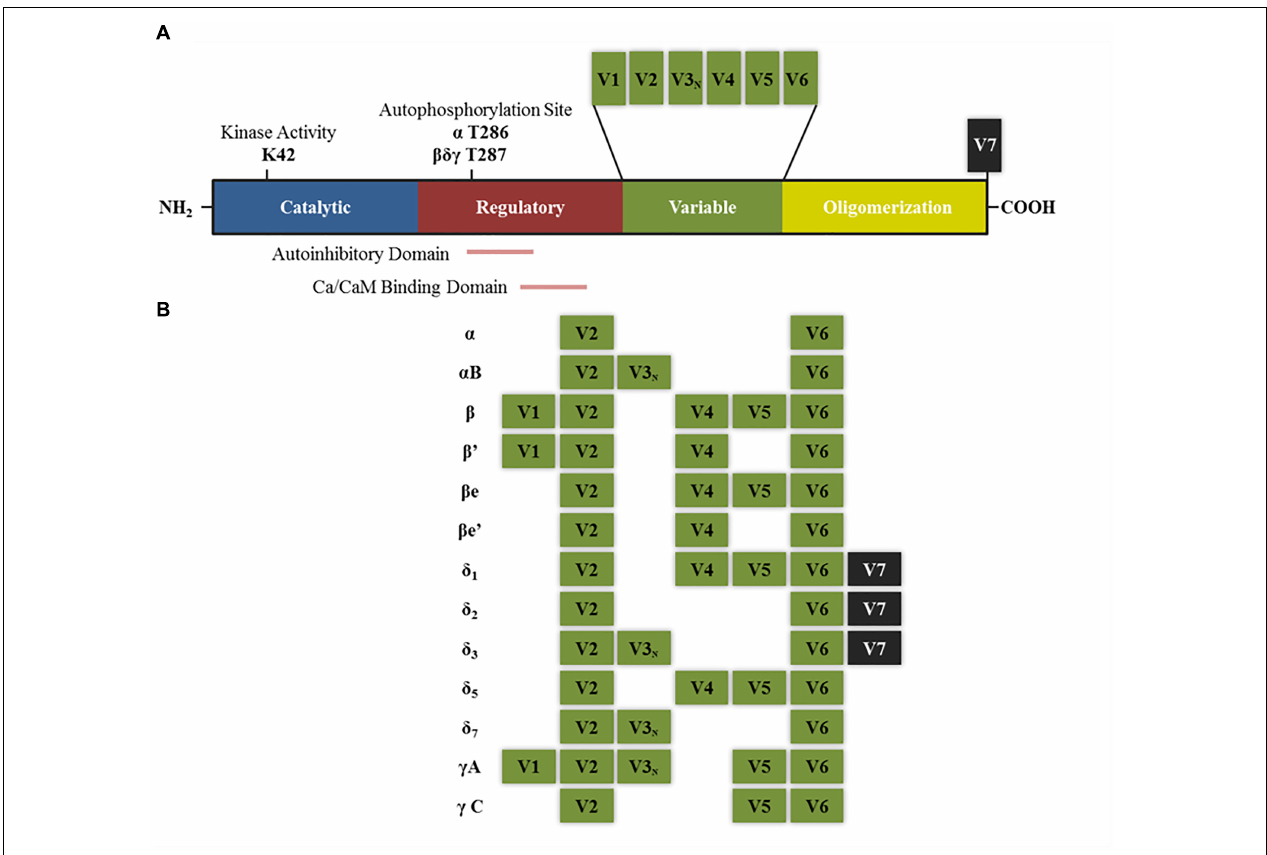
FIGURE 1 | Structure of CaMKII isoforms and splice variants. (A) General structure of CaMKII protein including the different functional domains and main key regulatory sites. K42 denotes the lysine residue that allows ATP binding. T286 and T287 are the threonine residues that are autophosphorylated upon calcium binding. Other sites not mentioned in the text are T305–T306 present in the Ca/CaM binding domain, which can be phosphorylated after CaMKII autophosphorylation and negatively regulates its activity by preventing further calcium binding (Coultrap and Bayer, 2012). (B) Splice variants for α , β , δ , and γ isoforms that have been described in neurons. V denotes variable region and V3 N represents the variable region containing the nuclear localization signal. “e” Denotes that these isoforms are expressed in embryonic stages (adapted from Tombes et al., 2003).